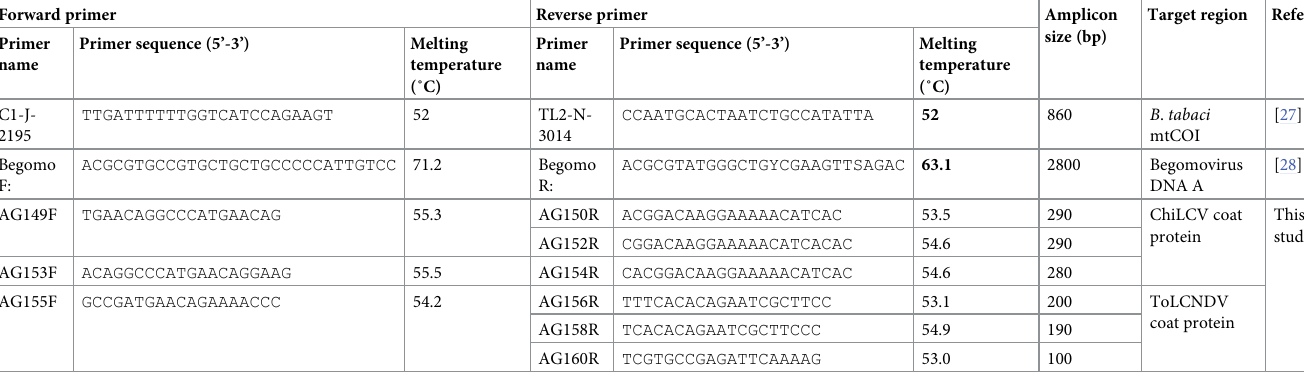
Table 1. List of primer pairs used in the study. Forward